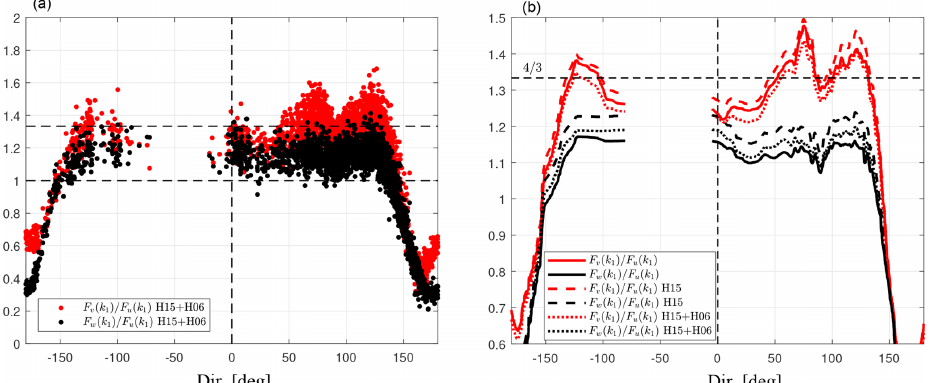
Figure 7. Velocity spectra ratios by the CSAT3 at the Risø test site as a function of wind direction for each 10min period after applying the corrections in H15 and H06 (a) and loess fits of the scatter (b) . Horizontal and vertical dashed lines as in Fig. 4. The standard error of the fit to the w to u velocity spectra ratios is within